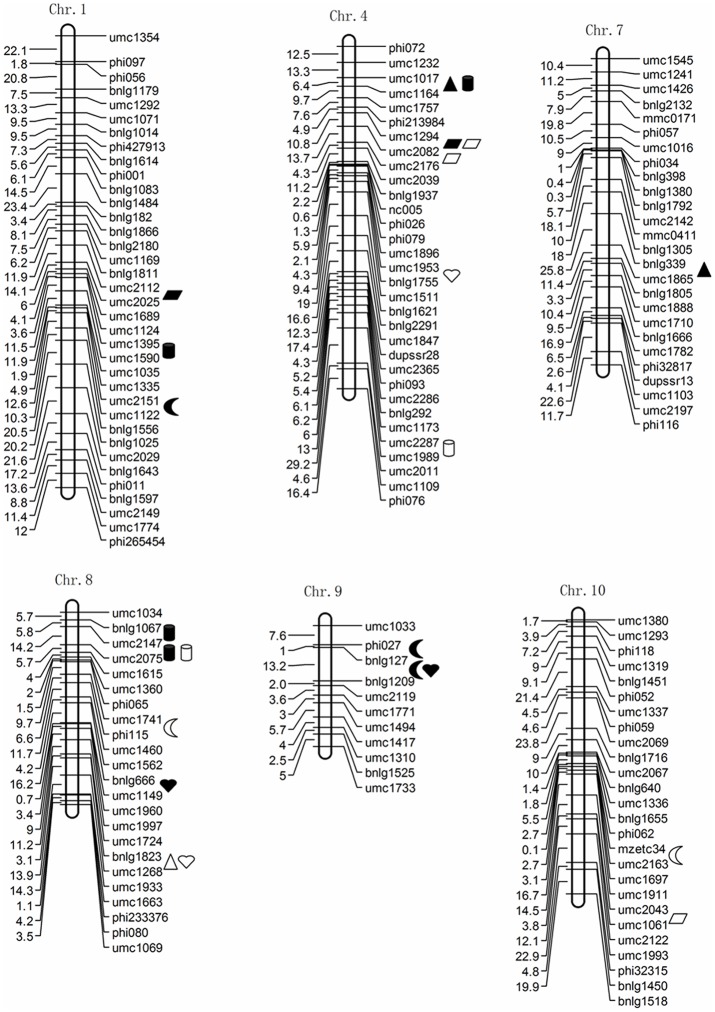
Chromosomal locations of QTLs for Hg concentration for five maize tissues.Note: Moon QTL detected for Hg content in kernels, Triangle QTL detected for Hg content in the axis, Cylinder QTL detected for Hg content in stems, Heart QTL detected for Hg content in bracts, Quadrangle QTL for Hg content in leaves. Black indicates a QTL detected in Xixian, and lucidity indicates a QTL detected in Changge.